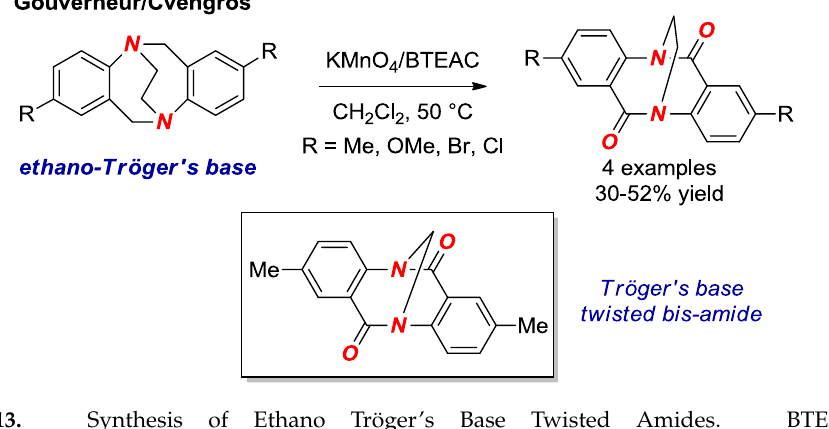
Figure 13. Synthesis of Ethano Tröger’s Base Twisted Amides. BTEAC = Benzyltriethylammonium Chloride.